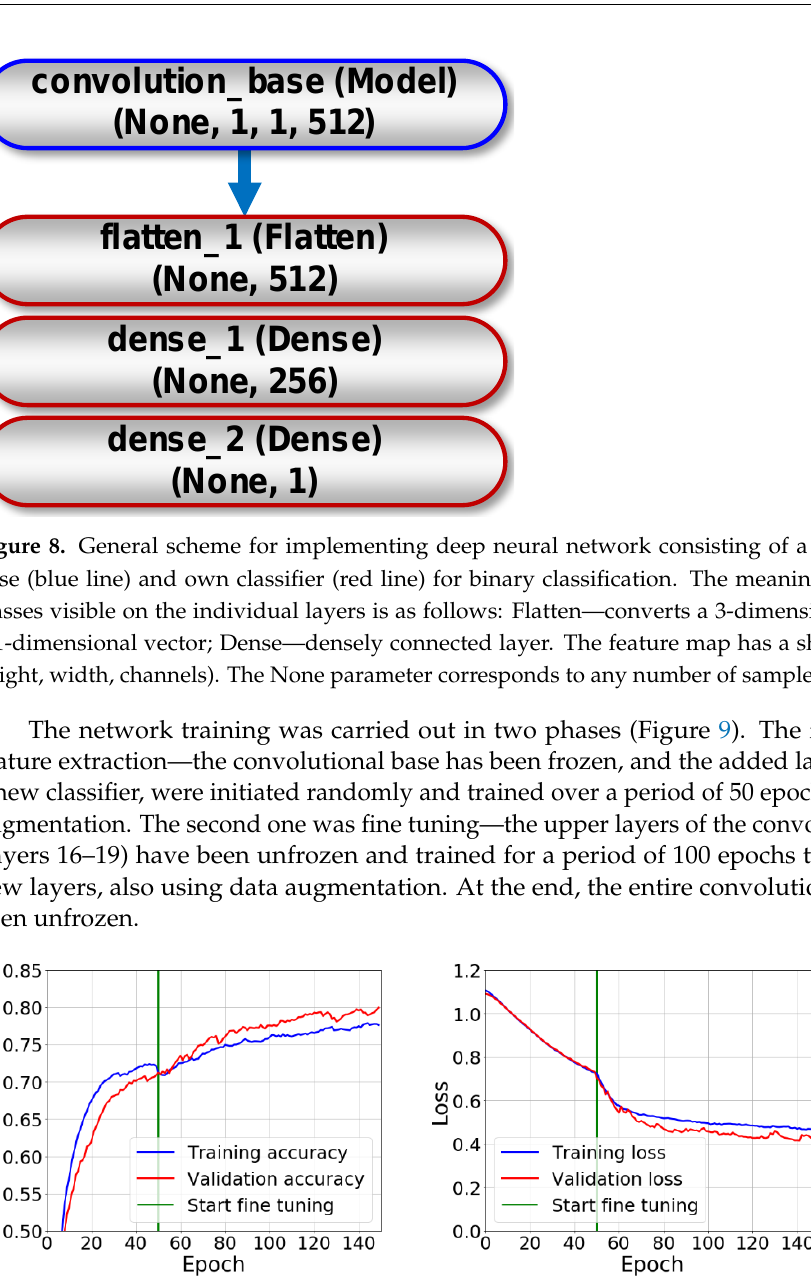
Figure 9. Sample plots of the accuracy ( a ) and loss ( b ) of training and validation processes for Variant 1 vs. 2 vs. 3. During the first 50 epochs, new layers of the network are trained, while the whole convolutional base is frozen (feature extraction). Then the fine tuning starts, during which the upper layers of the convolutional base are unfrozen and tuned for a period of 100 epochs together with the new classifier.